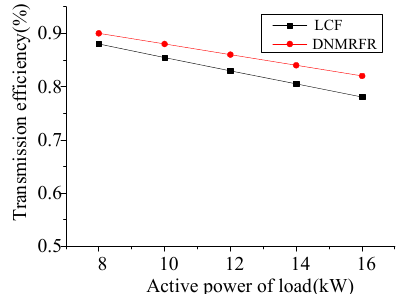
Figure 22. Comparison of power transmission characteristics of two kinds of filters.